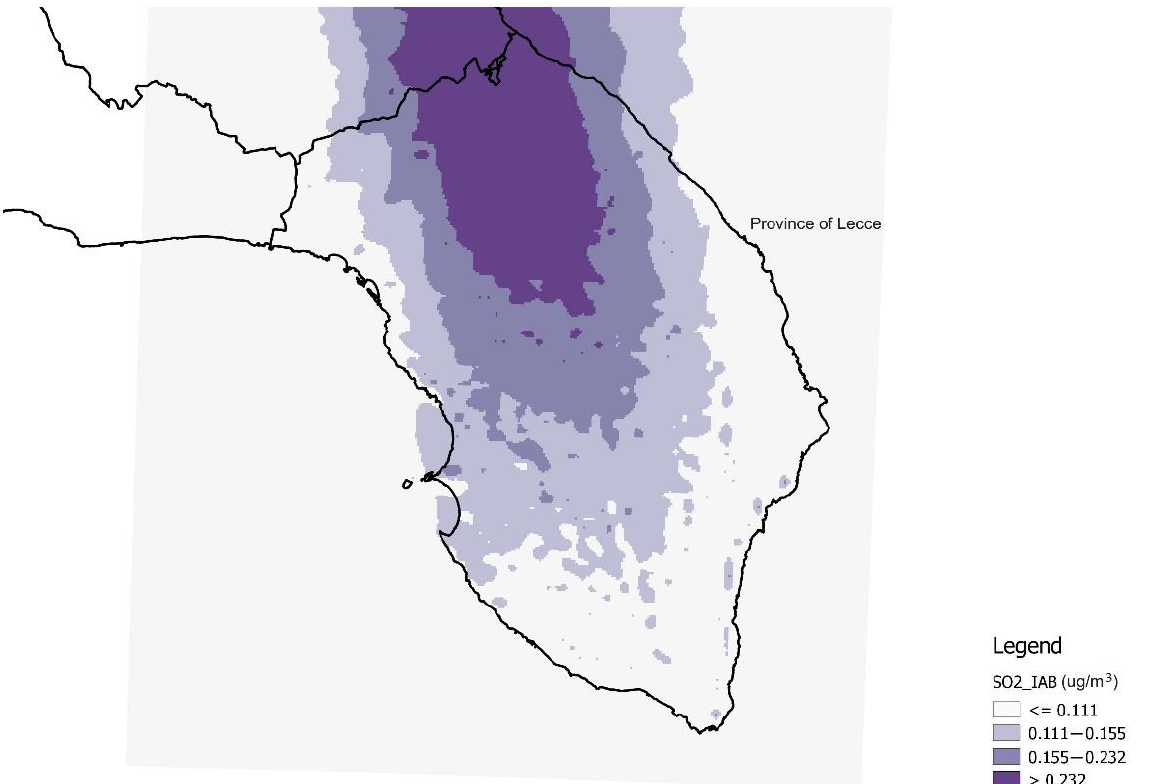
Figure 4. Exposure classes according to the quartiles of the sulfur dioxide distribution of the Industrial Area of Brindisi (IAB) (SO 2 _IAB), attributed to georeferenced subjects (values in µg/m 3 ).